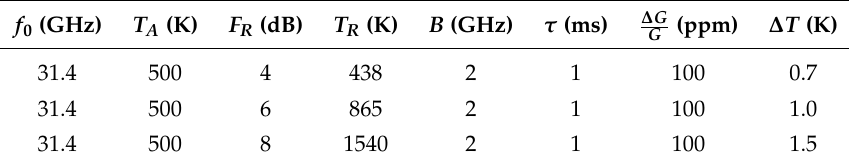
Table 5. Main instrument parameters.